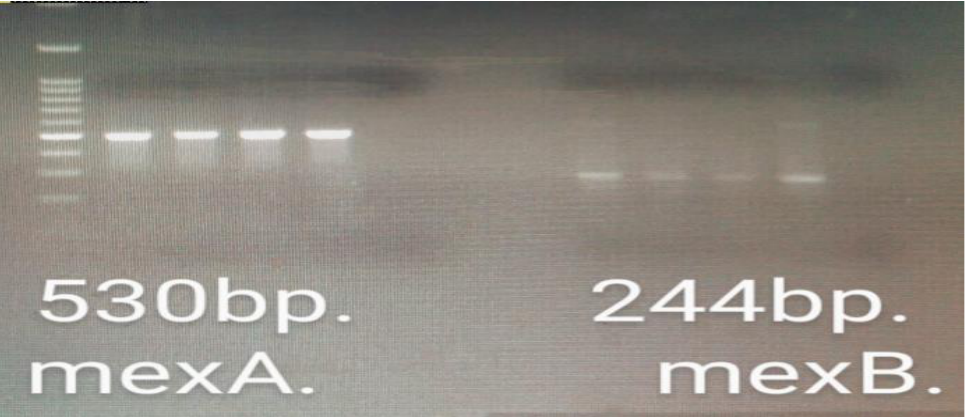
Figure 1. Agarose gel electrophoresis of PCR-assay for identification of MexA and MexB gene. MexA gene was detected at 530 bp and MexB was detected at 244bp.